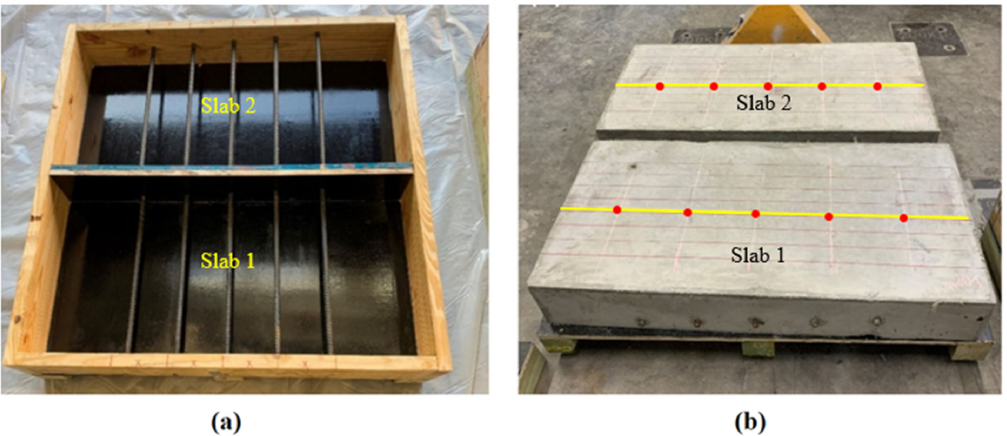
Figure 5. Slab 1 and Slab 2: ( a ) before and ( b ) after casting.